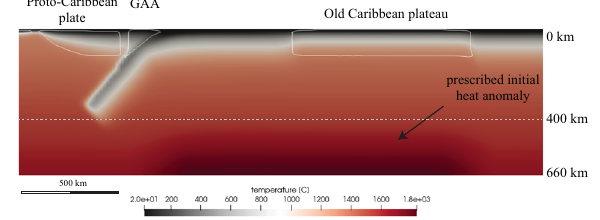
Fig. 5 | Initial temperature conditions for simulations using the extended Boussinesq approximation. Cross-section showing the initial the mantle tem- perature anomaly prescribed in simulations using the extended Boussinesq approximation. The mantle thermal anomaly, representing a deep sourced plume head,isinitiallyprescribedunderneaththeoldCaribbeanplateaubetween400and 660kmdepth.Inthisregion,theadiabaticgradientiselevatedfollowingagradient of 0.8 °C.km-1. GAA Greater Antilles Arc.